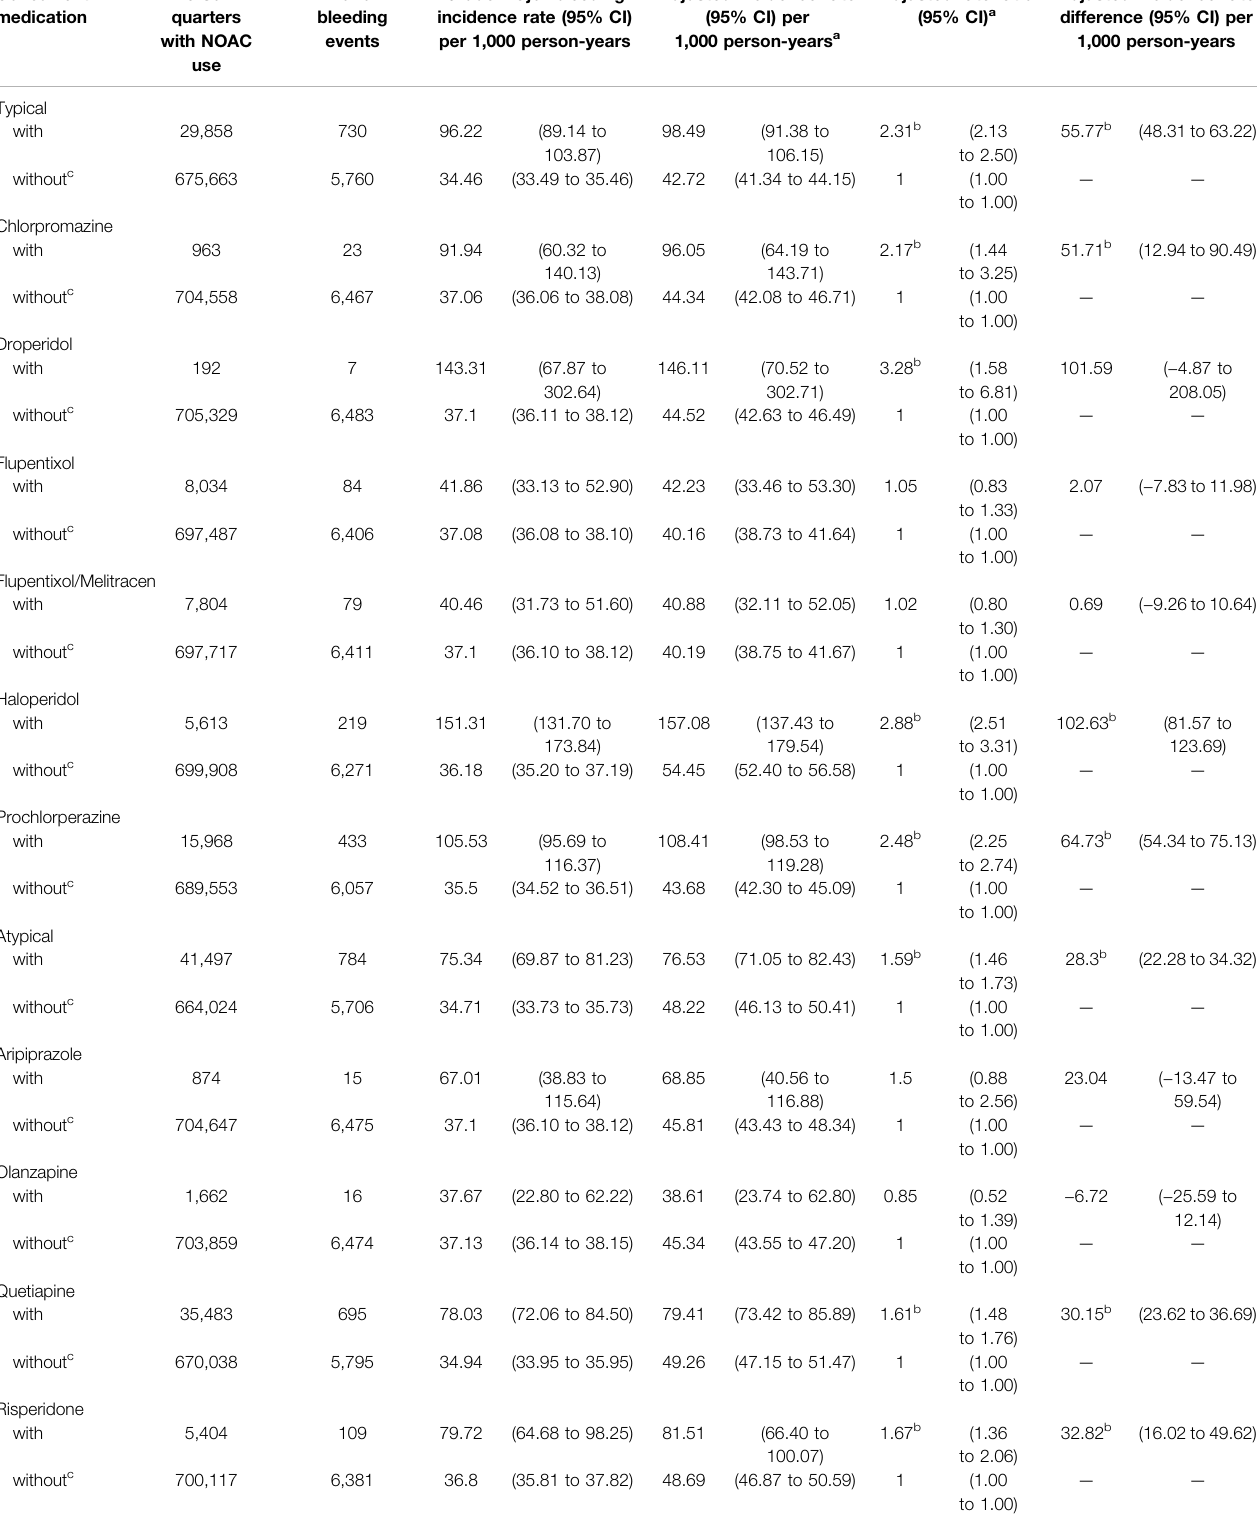
TABLE 5 | Risk of gastrointestinal hemorrhage among AF patients taking non-vitamin-K antagonist oral anticoagulants with or without concurrent antipsychotics. Concurrent